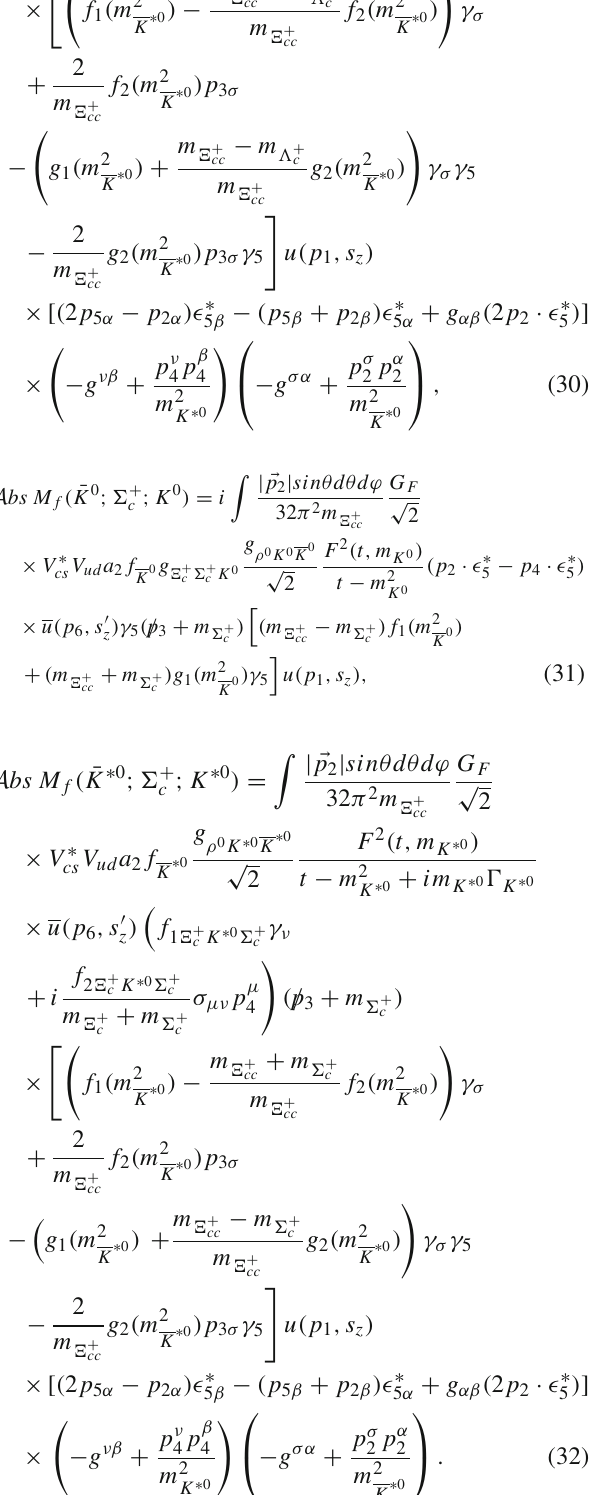
and f η are calculated 8 1